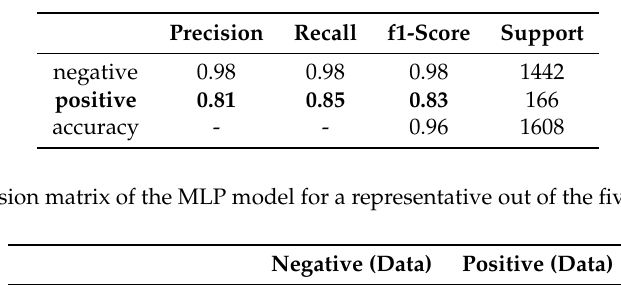
Table 3. Performance of the MLP Model for a representative out of the five folds (test set).